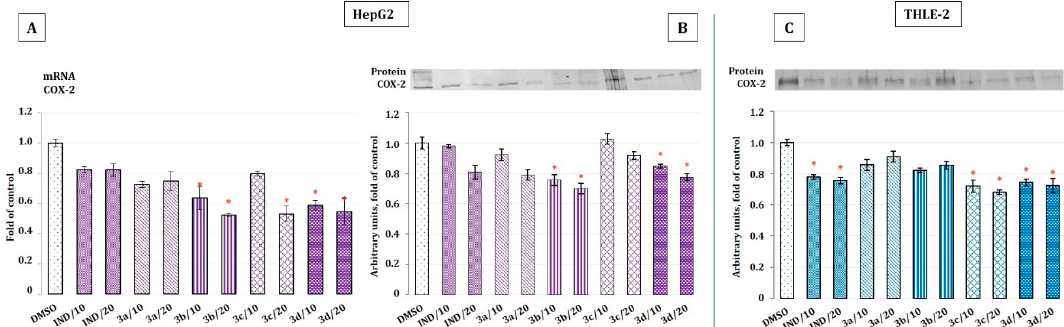
Figure 6. The effect of IND and OAO–IND derivatives ( 3a, 3b, 3c, and 3d ) on the level of COX-2 mRNA ( panel A ) and protein level in HepG2 ( panel B ) and THLE-2 ( panel C ) cells. The values (means ± SEM) for the mRNA level of COX-2 in HepG2 cells ( panel A ) were calculated from three separate experiments in comparison with control cells (expression equals 1). Representative immunoblots of the cytosolic content of COX-2 in HepG2 ( panel B ) and THLE-2 cells ( panel C ) from three separate experiments are shown. The sequence of the bands corresponds to the sequence of the bars in the graph. The values (means ± SEM) were calculated as protein level in comparison with control cells (expression equals 1). * Significantly different from DMSO (control)-treated cells, p < 0.05.